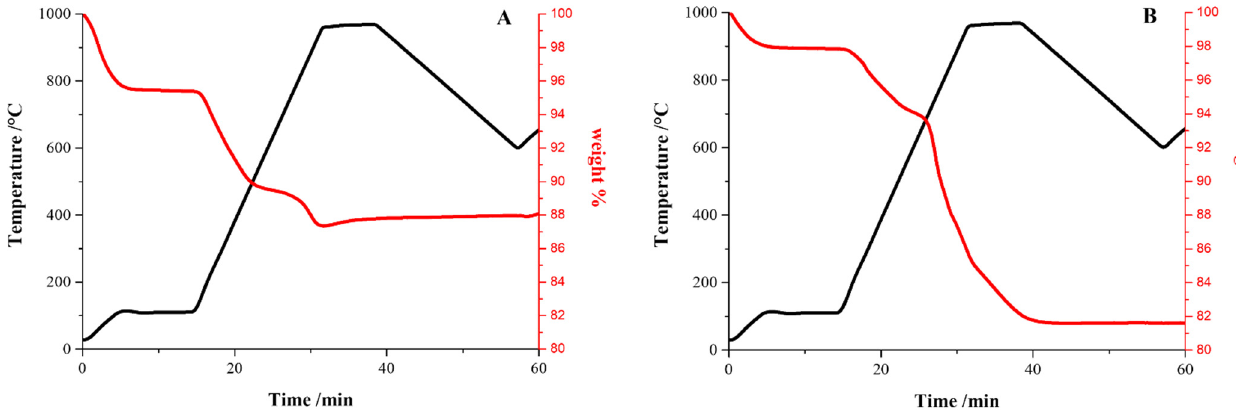
Figure 2. TGA curves of Mel/TiO 2 ( A ) and Mel/ZnO ( B ) nanoparticles.